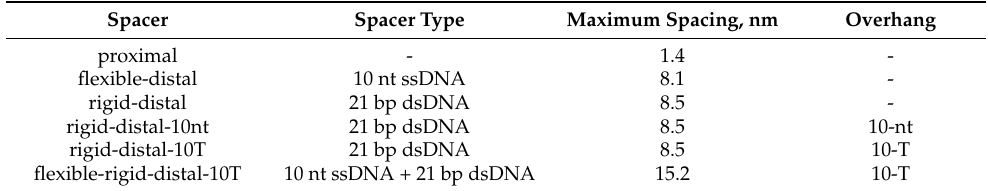
Table 3. Different spacer designs tested. The theoretical maximum spacing between the cholesterol and DOT is estimated here using 0.34 nm/bp for dsDNA [45], 0.67 nm/nt for ssDNA [46], and cholesterol-TEG linker length of 1.4 nm [42]. The actual spacing is likely to be smaller, especially for the flexible